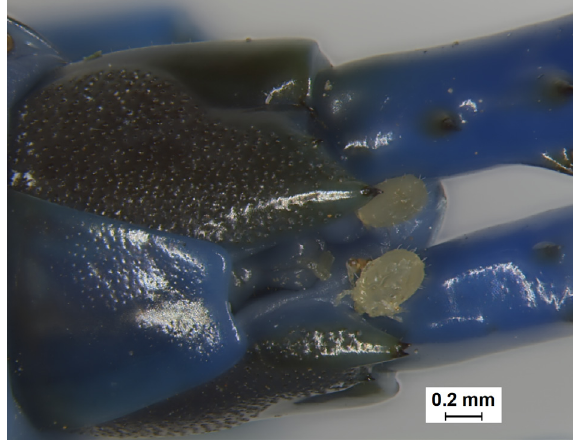
Image 9. Ectoparasitism of acari on Digitipes